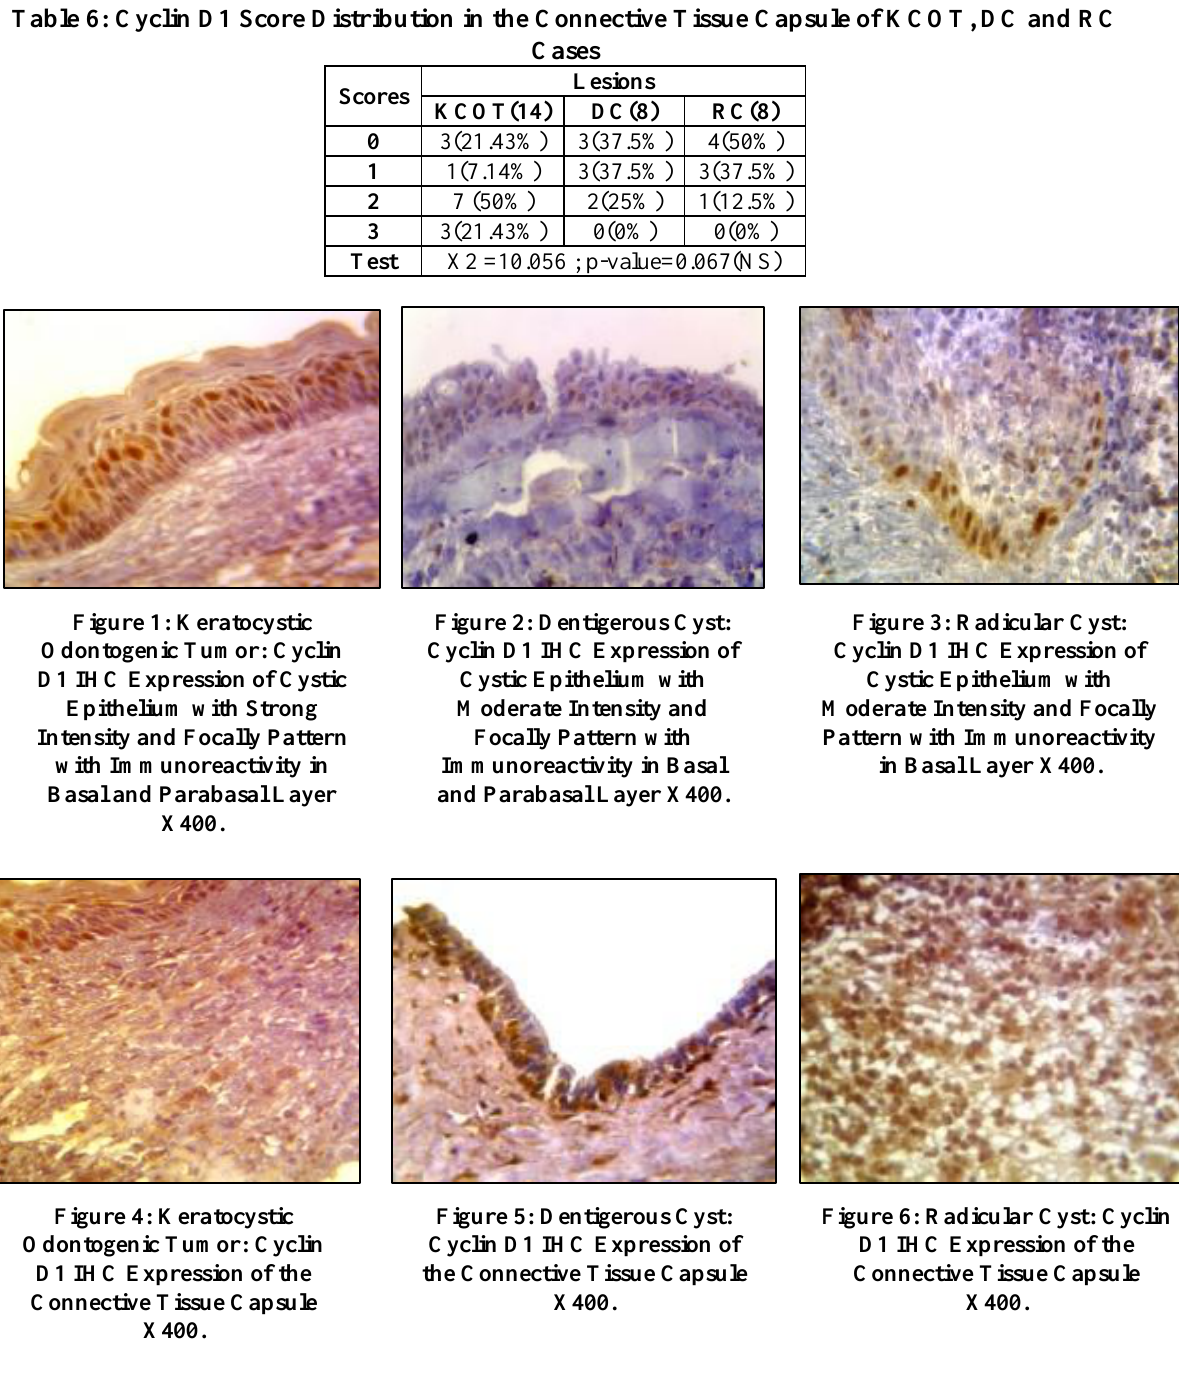
Figure 4: Keratocystic Odontogenic Tumor: Cyclin D1 IHC Expression of the Connective Tissue Capsule X400.